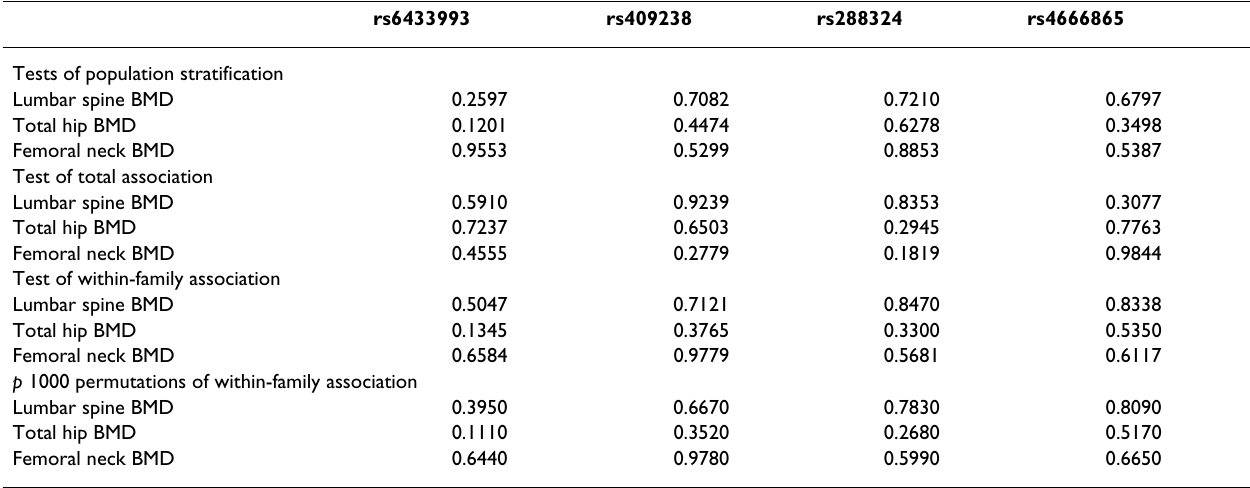
Table 4: P values of QTDT analyses for FRZB gene and BMD in female-offspring nuclear